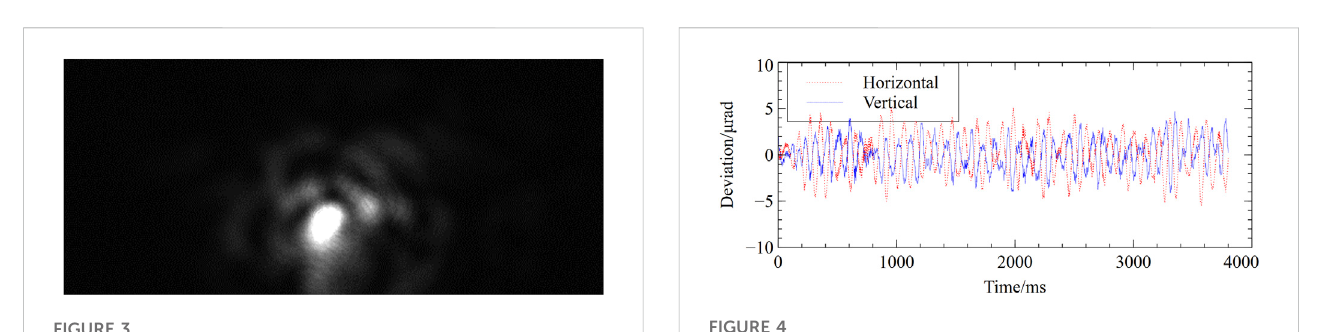
FIGURE 3 Beam far- fi eld distribution on high-speed camera.